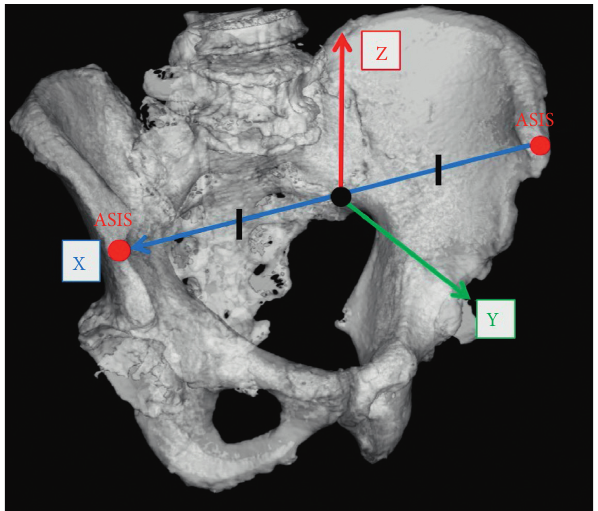
Figure 1: Functional pelvic plane coordinate system. The origin (white point) coincident with the middle point of the left and right anterior superior iliac spine